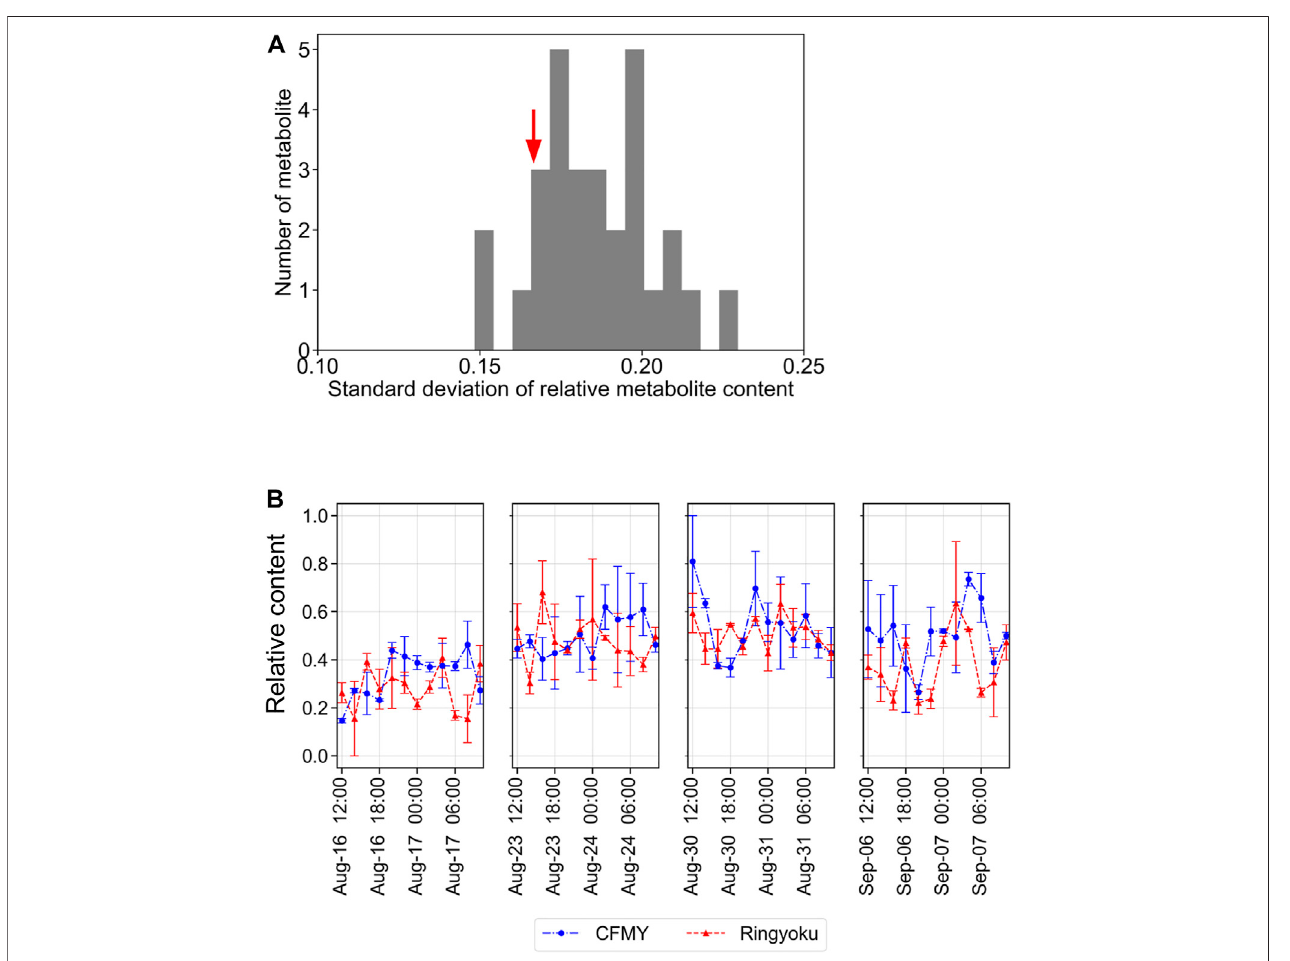
FIGURE 6 | Diurnal fl uctuations of metabolite content in tomato leaves. (A) Distribution of the standard deviations of 29 metabolites. The red arrow indicates the standard deviation of trigonelline at 0.167. (B) Diurnal fl uctuations of the relative content of trigonelline (scaled between 0 and 1).